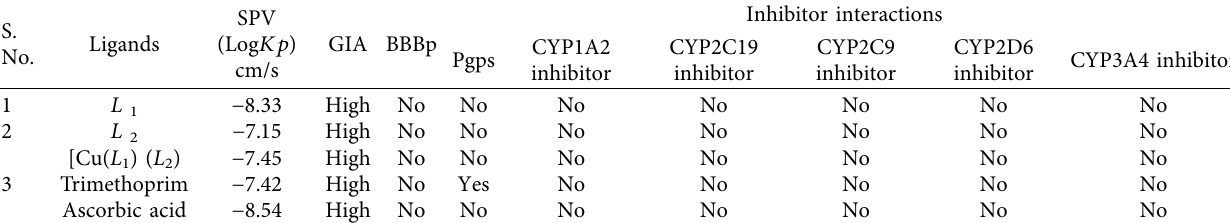
Table 7: ADME expectations worked out by Swiss ADME and preADMET.